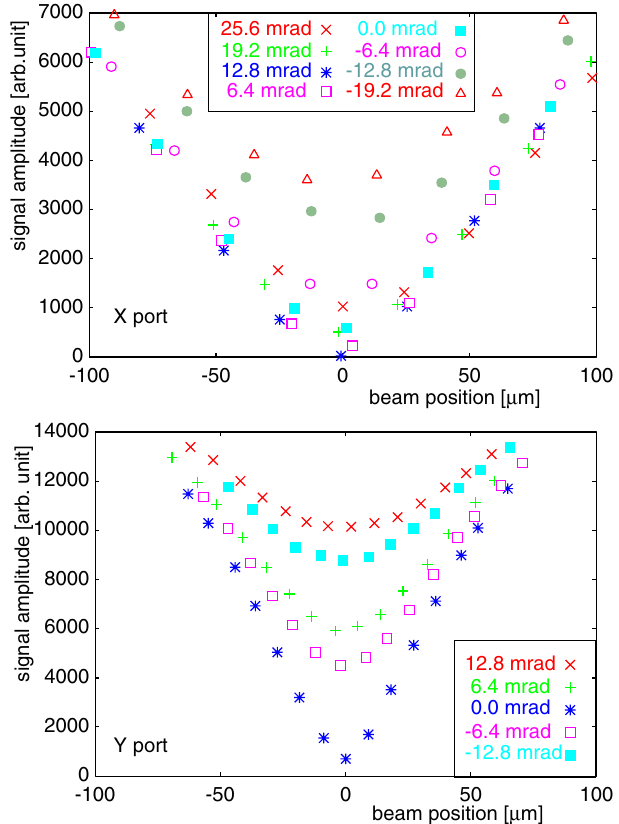
FIG. 9. (Color) The result of angle sensitivity measurement. The top and the bottom plots are the data of the X direction and the Y direction,